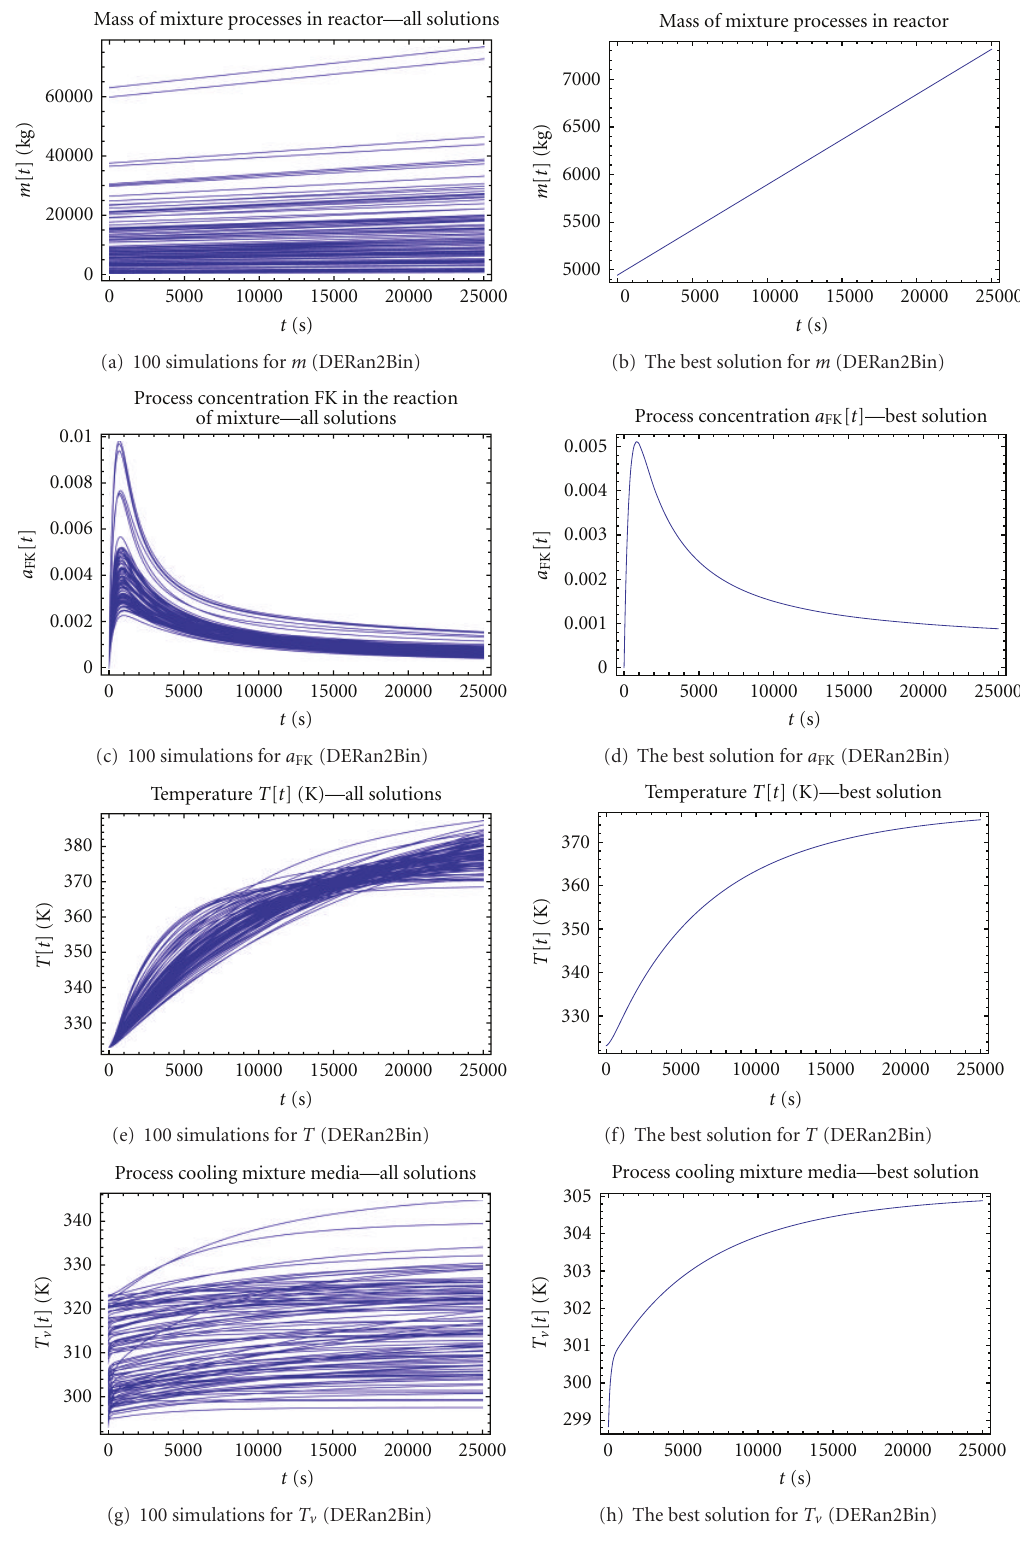
Figure 8: Processes parameters for 100 simulations of DE—version